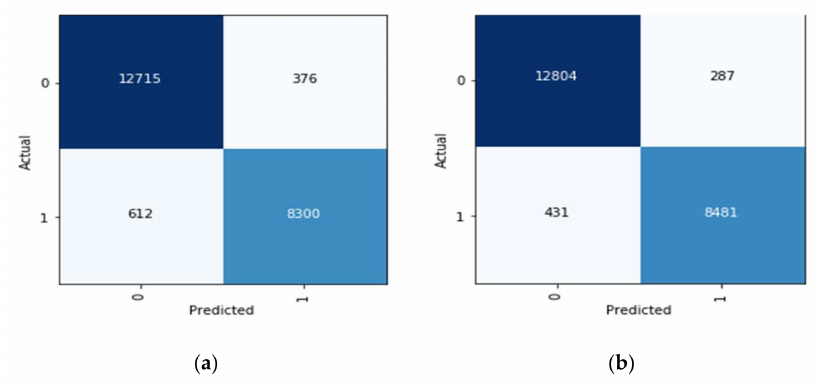
Figure 12. ( a ) Confusion matrix for DenseNet-169 ( b ) Confusion matrix for fine-tuned